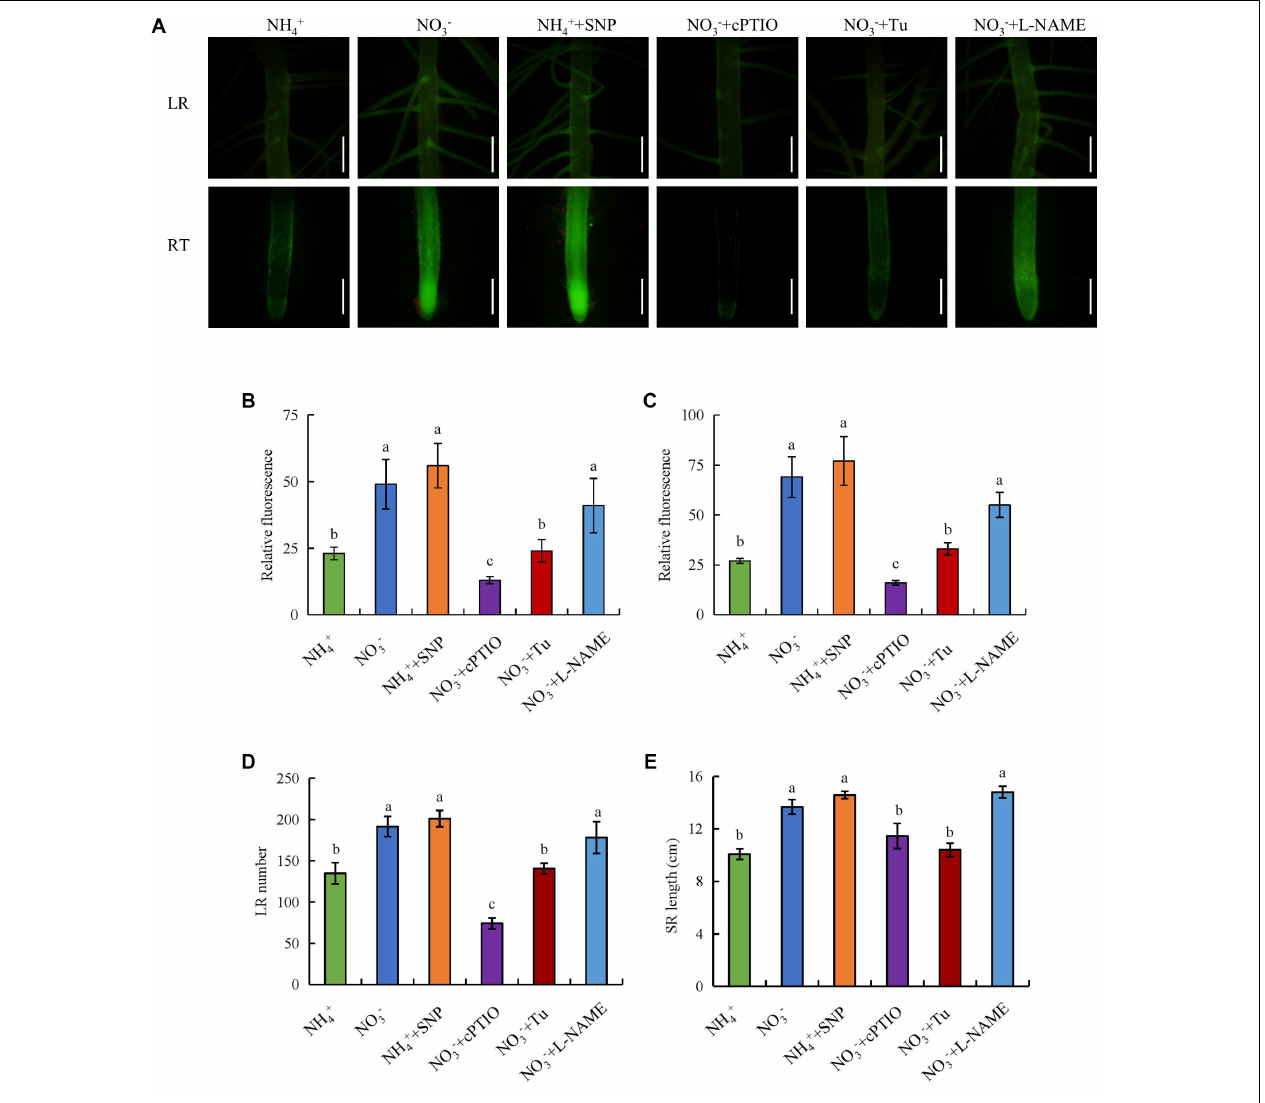
FIGURE 3 | Accumulation of nitric oxide (NO) and root morphology in wild-type (Nipponbare). Seedlings were grown in hydroponic medium containing NH 4 + and NO 3 − in addition to SNP (10 µ M), cPTIO (100 µ M), Tu (25 µ M) and L-NAME (100 µ M) for 14 days. (A–C) , Photographs of NO production shown as green fluorescence in the lateral root (LR) and root tip (RT) (A) , and NO production expressed as fluorescence intensity relative to lateral root (B) and root tip (C) ; (D) , Lateral root (LR) number; (E) , Seminal root (SR) length. Bar = 1 mm. Data are means ± SE and bars with different letters indicate significant difference at P < 0.05 tested with